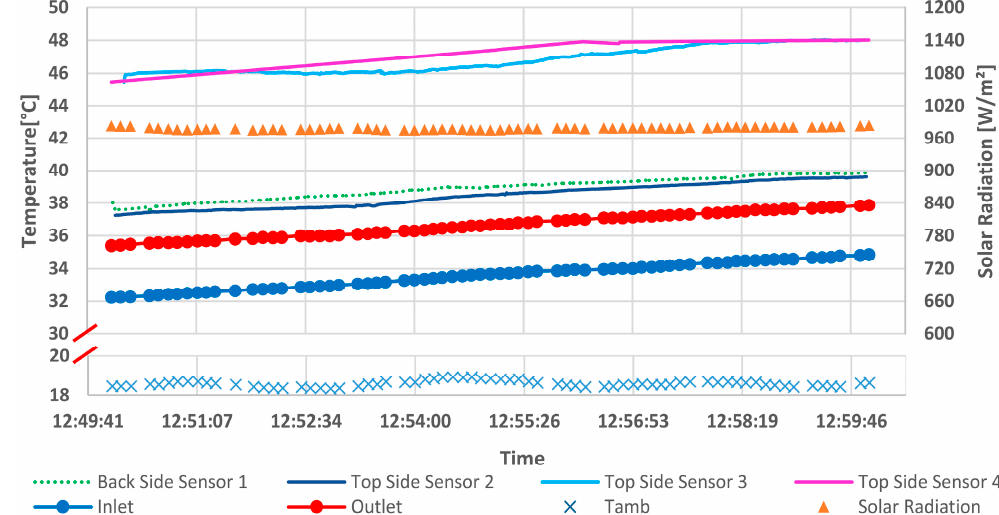
Figure 10. Measurement A: layers, water and ambient temperatures and solar radiation. The flow rate of measurement: 2.2 L/min.